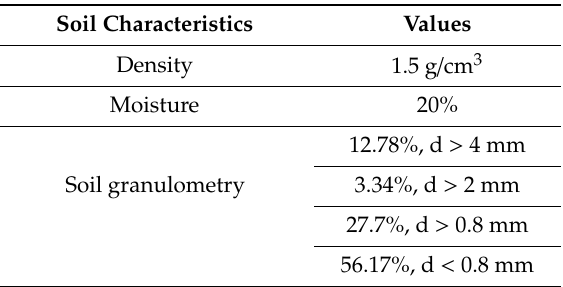
Table 1. Main characteristics of the soil used in the experiments.